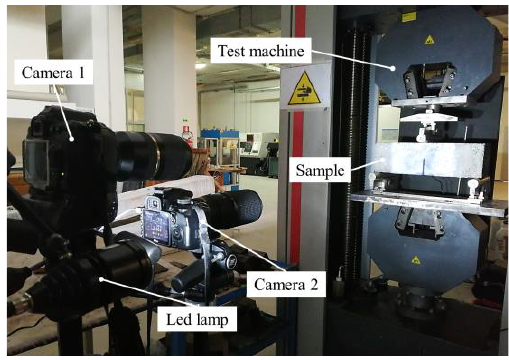
Figure 8. Experimental DIC test setup.